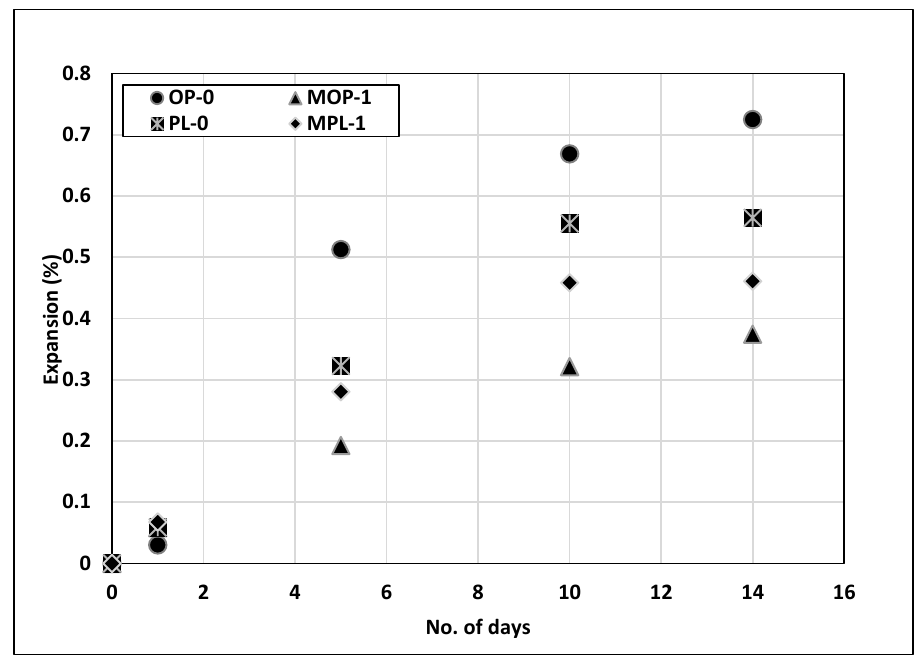
Figure 9. Results of alkali silica reaction (ASR) test.